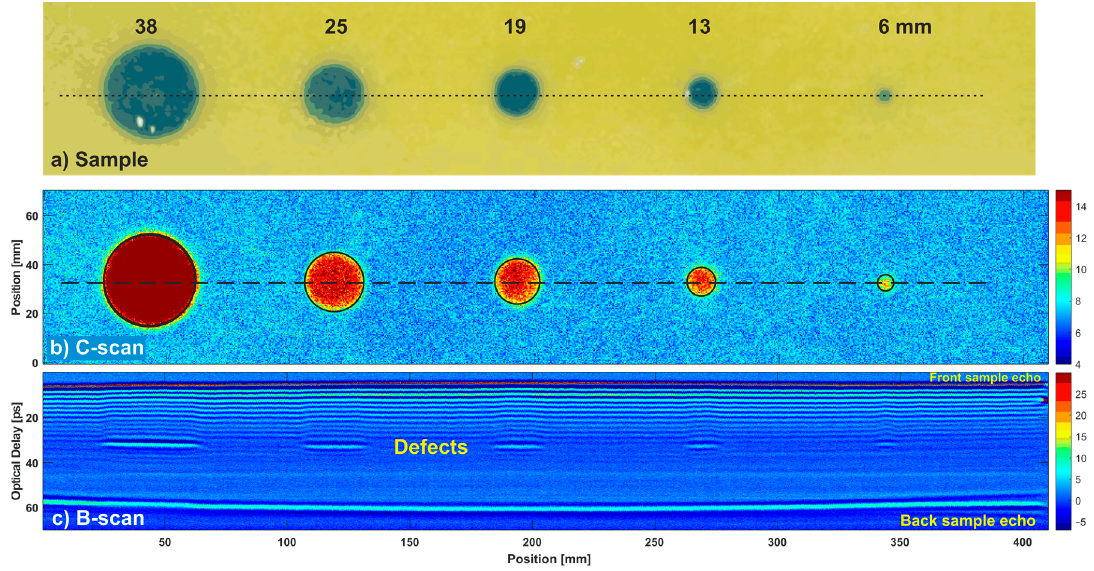
Figure 10. The glass-fiber composite sample with circular defects: photo ( a ), C-scan ( b ) and B-scan ( c ) of the defects. Line-by-line scheme without averaging.